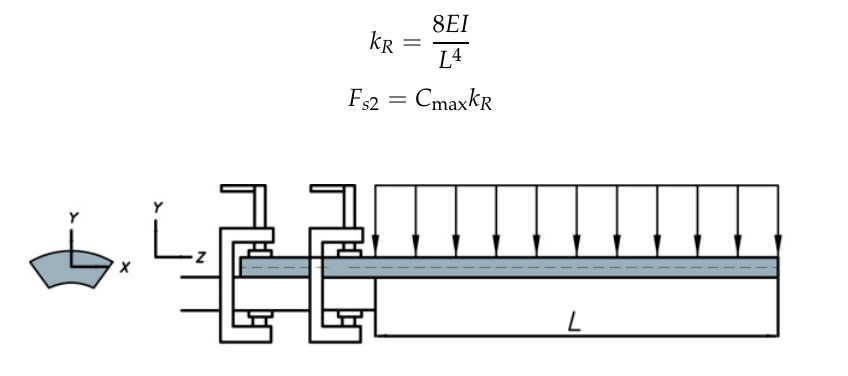
Figure 10. Equivalent representation of a jaw of the collet.